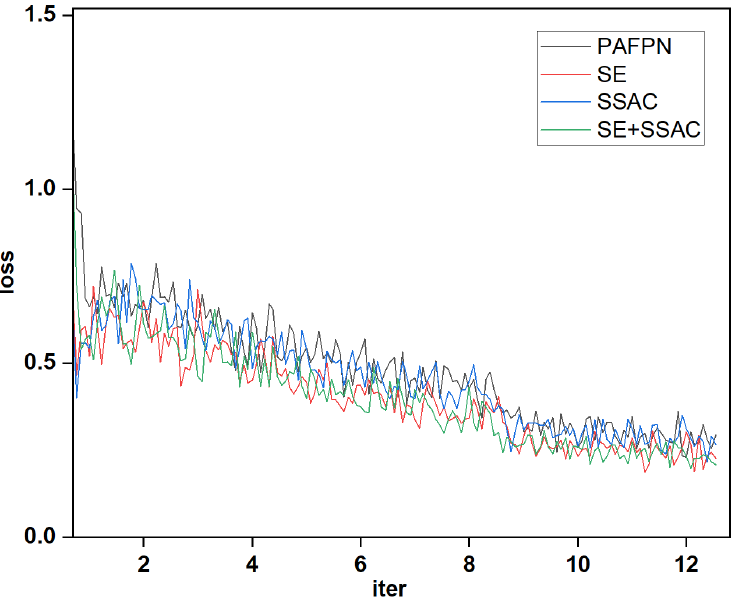
Figure 7. Comparison of the training loss of PAFPN, SE, SSAC and SE+SSAC during 12 training